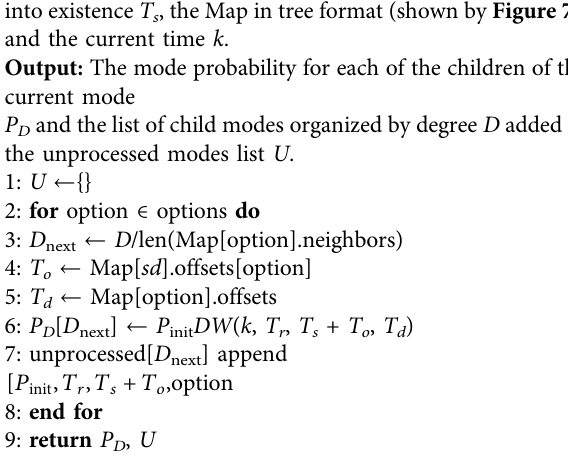
FIGURE 7 | Branching probabilities. Mode Splitting Analysis for a 3 × 3 map. A3 × 3mapisagridcomprisingofninenodesina3 × 3layoutwitheach edge